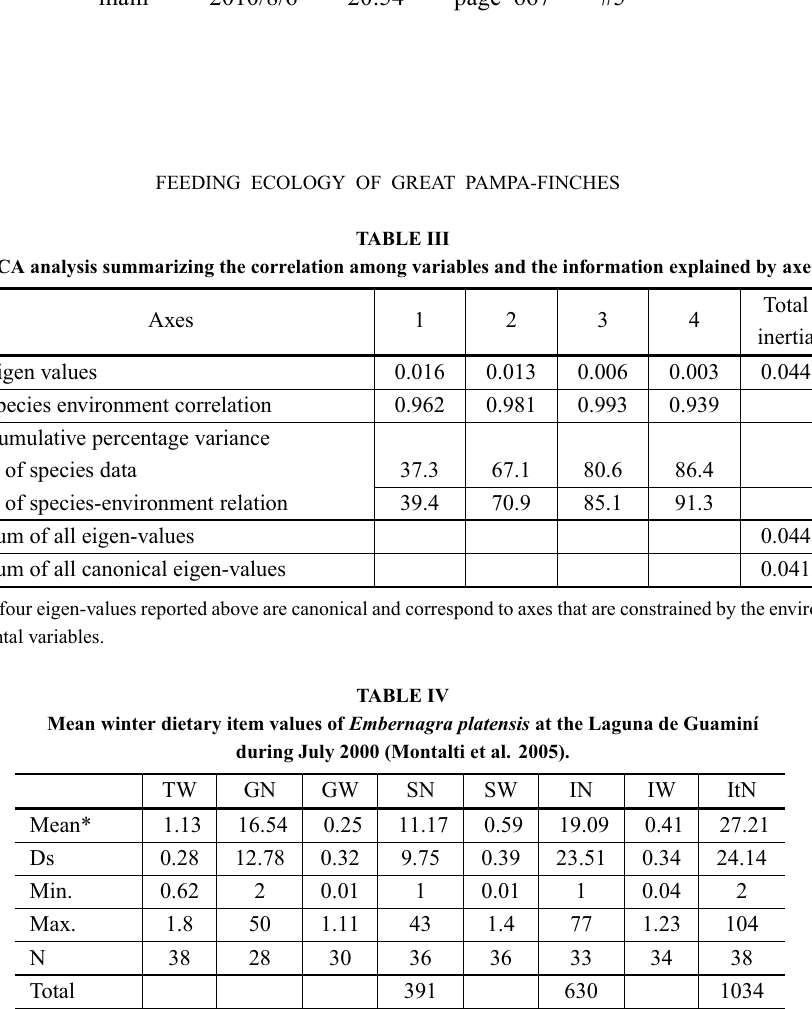
*Mean values were based on N = 38 stomach contents collected during the winter. TW = total stomach content weight, GN = number of gastroliths, GW = weight of gastroliths, SN = seed number, SW = seed weight, IN = insect number, IW = insect weight, ItN = number of items.